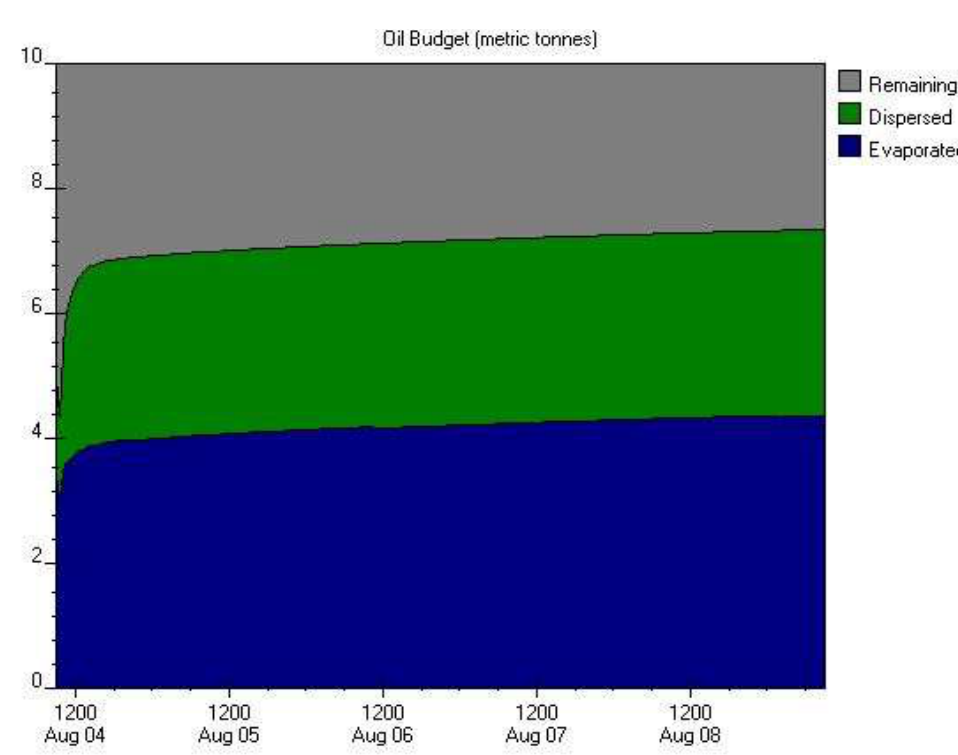
Figure 4. Oil budget: A view of an ADIOS spill scenario, showing remaining, dispersed, and evaporated oil (Arabian extra light (Aramco)) over time (from the ADIOS program).